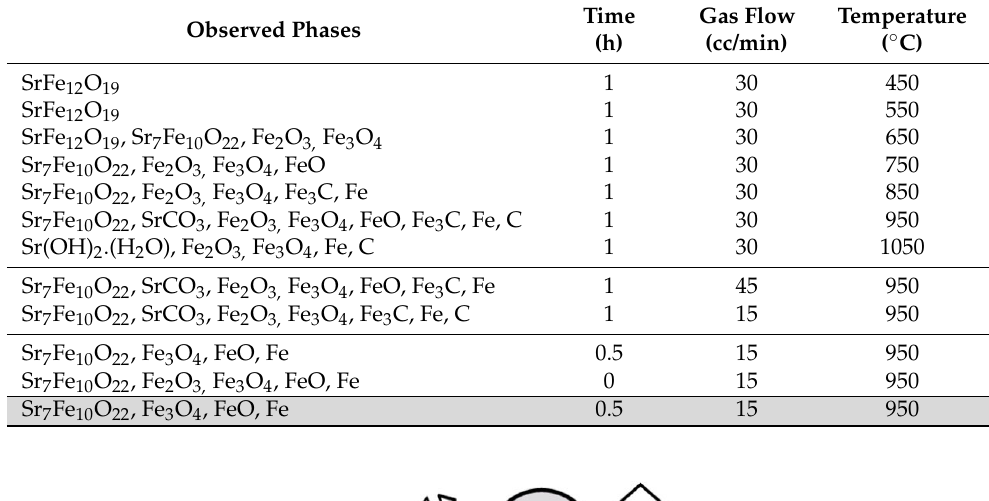
Table 1. Summary of all samples with different process conditions and their products.